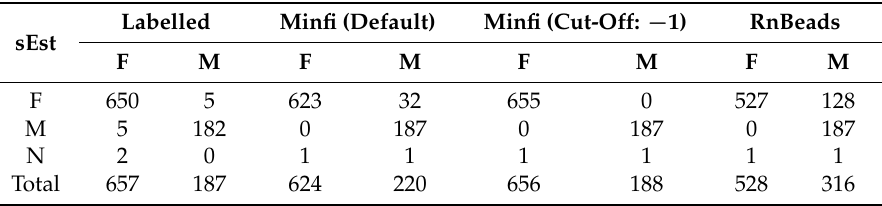
Table 3. Comparison of sex-estimation by sEst and existing